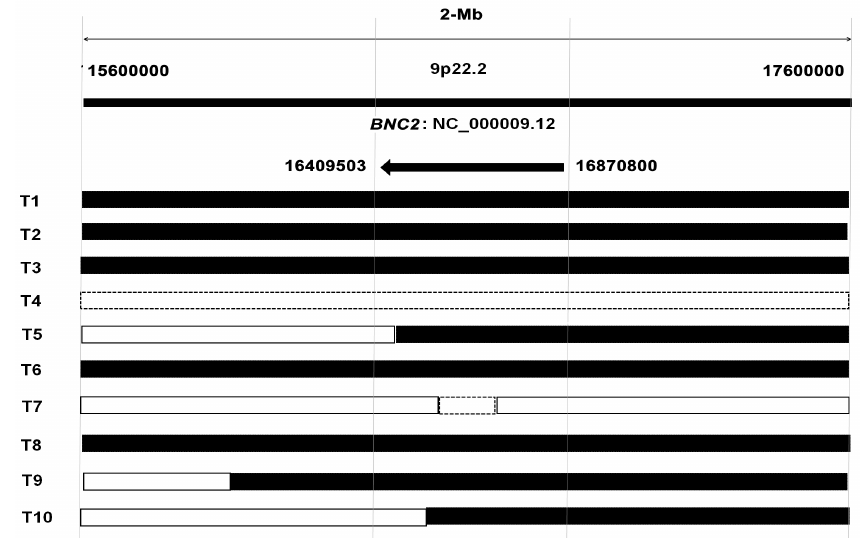
Figure 2. Chromosomal aberrance of BNC2 gene in HCC tissues. “T” represents tumor tissue; Black lines represent Chromosome deletion; the dotted lines represent Chromosome amplification and real lines represent normal status. 2-Mb: 2-Megabase.